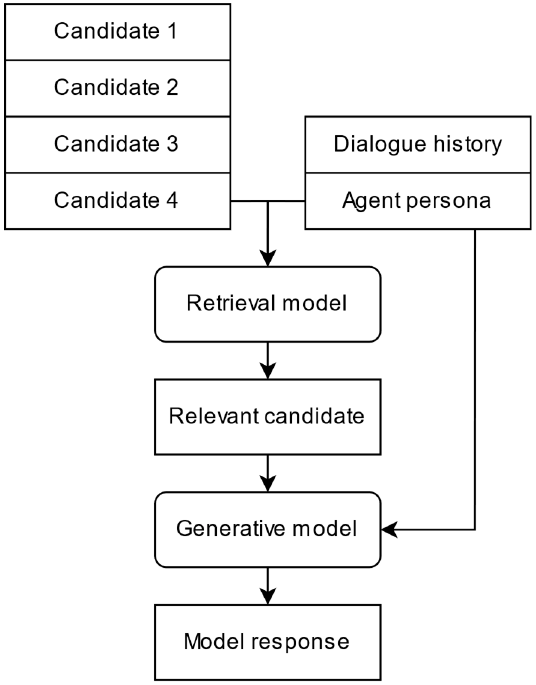
Figure 3. Retrieval and Personifier hybrid